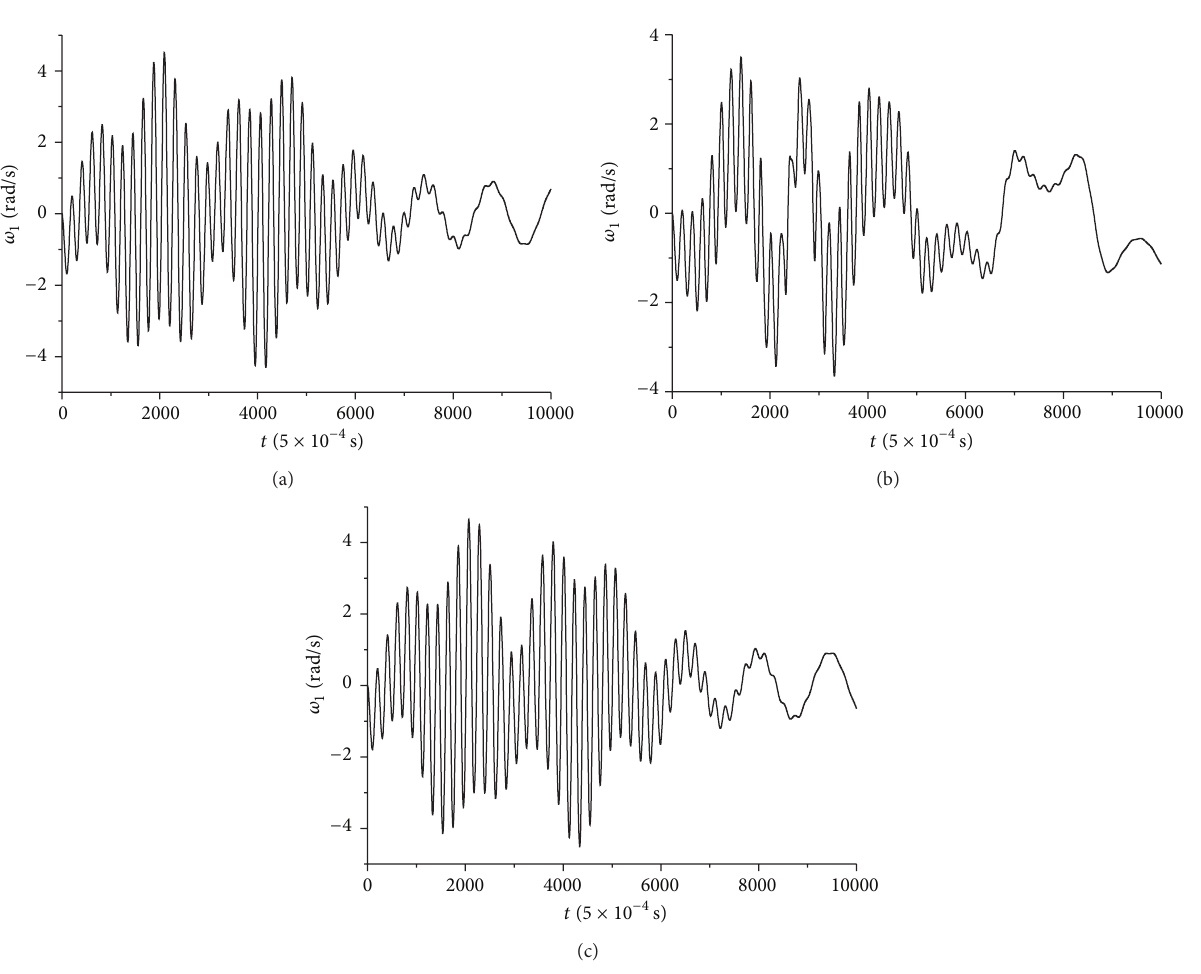
Figure 4: Ellipsoid spin rate 𝜔 1 time-series in the case of (a) wax, (b) gypsum, and (c) lead